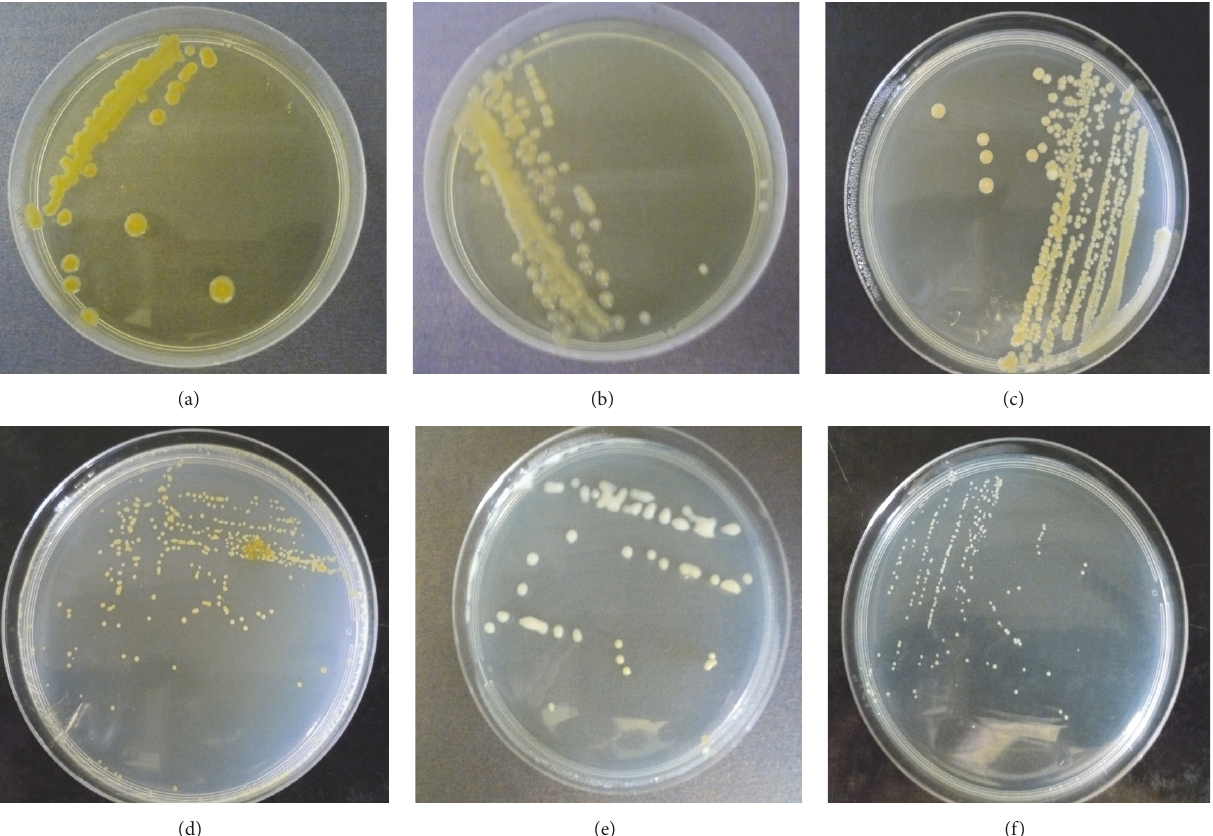
Figure 2: Colonies of rhizobia isolates on yeast mannitol agar medium containing bromothymol blue. (a) Yellow with creamy and smooth margins, medium sized, round, (b) cream with smooth margin, medium sized, round, (c) yellowish, smooth margins, medium sized, round (d) yellow, smooth margins, small sized, punctiform, (e) white, smooth margins, medium sized, round (f) white, smooth margins, small sized,